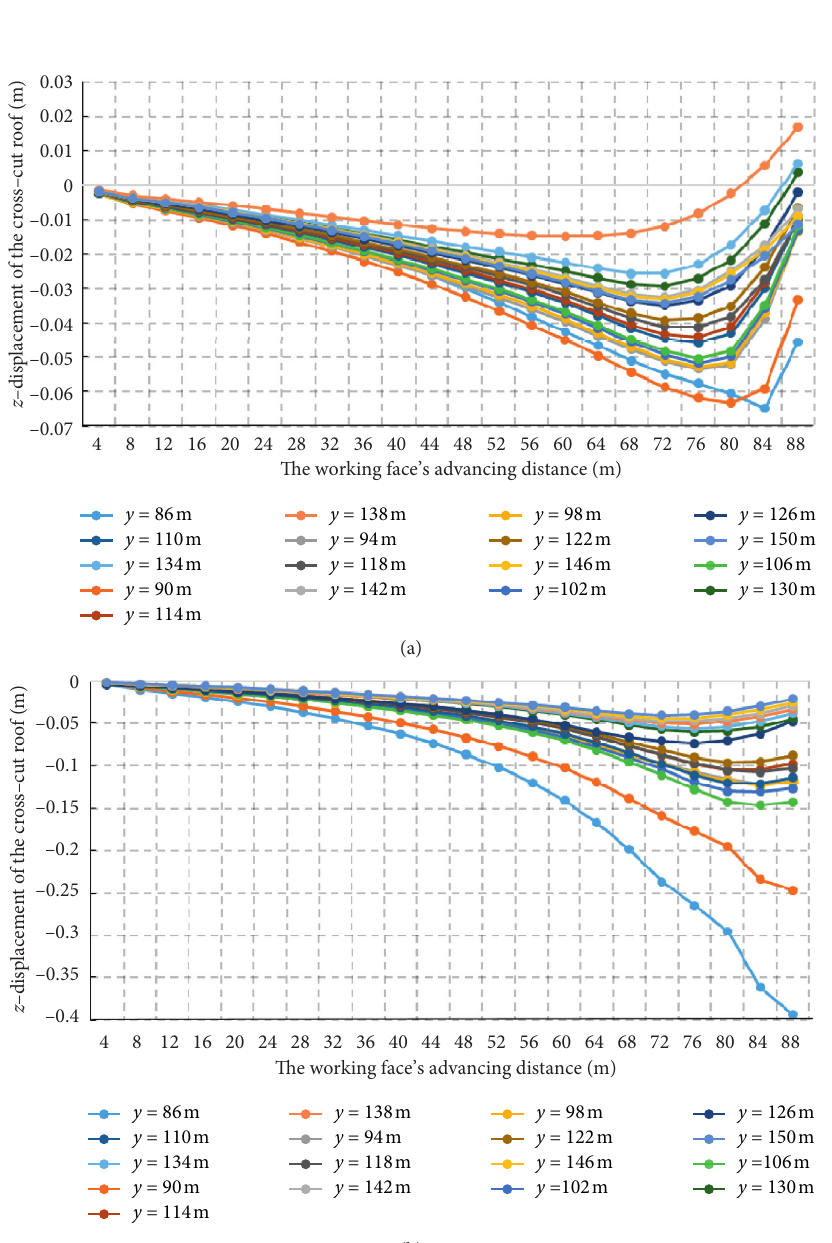
Figure 10: z -displacement of SAR section: (a) z -displacement of SAR section with backfilling and (b) z -displacement of SAR section without